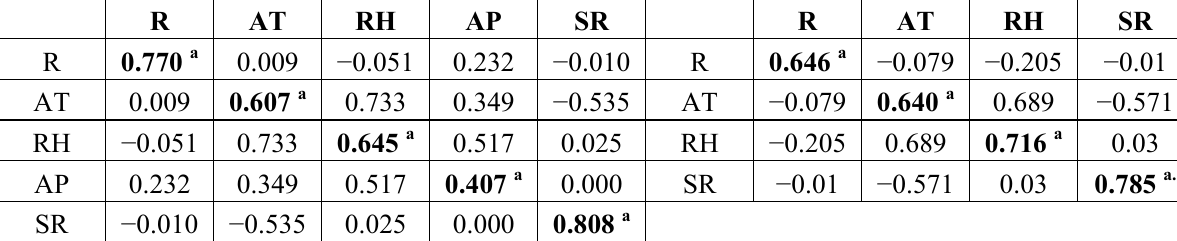
Table 2. Anti-image correlation matrix: including air pressure (left), without air pressure (right). R